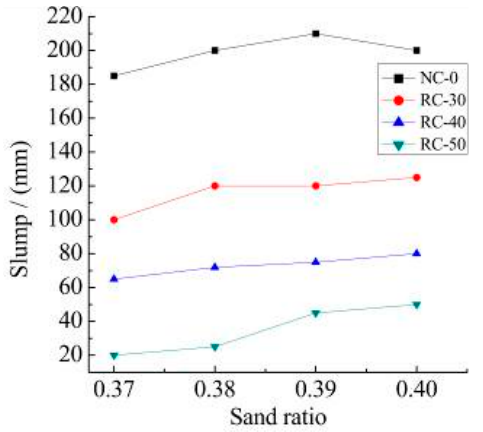
Figure 6. Measured recycled concrete slump with the different sand ratio.